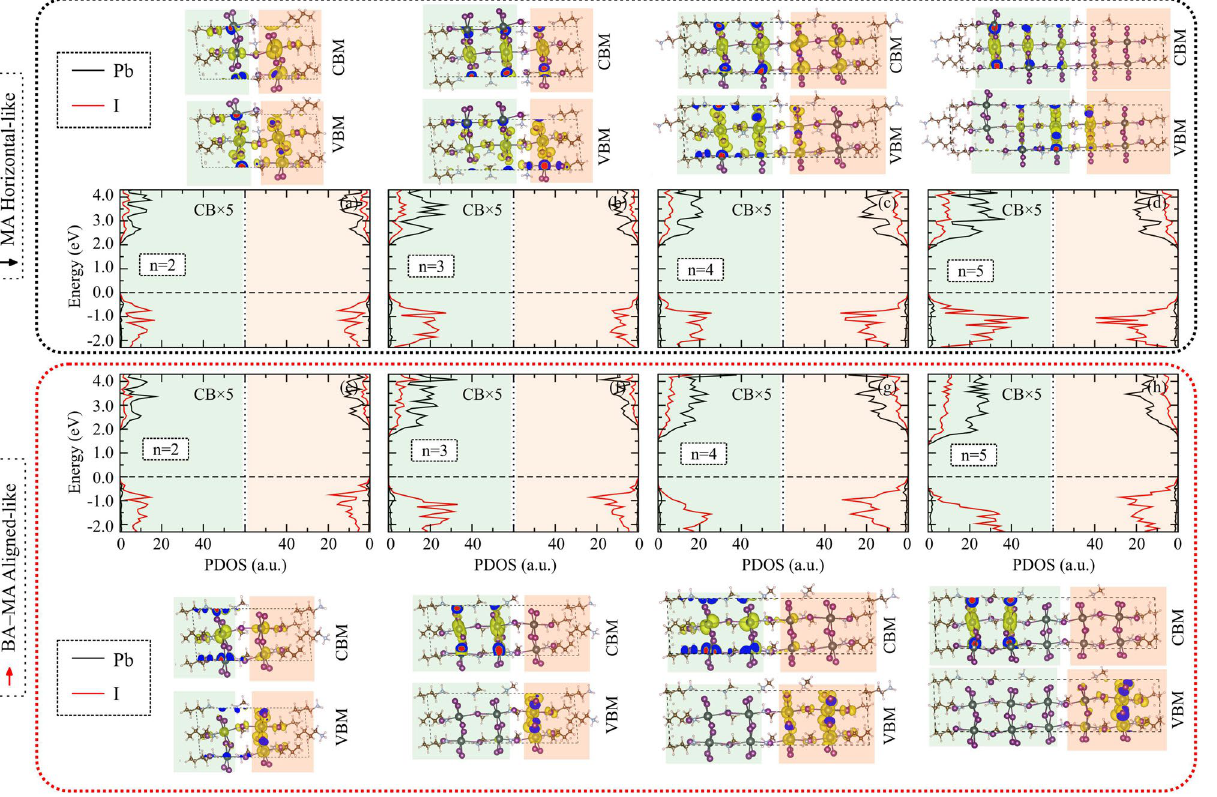
Figure 4. Projected density of states (PDOS) in the respective planes indicated by the corresponding blue and pink colors for the shaded regions in BA 2 MA n − 1 Pb n I 3 n + 1 for MA horizontal-like, from ( a ) to ( d ), and BA-MA aligned-like, from ( e ) to ( h ). Orbital representations in VBM and CBM are above and below the PDOS for MA horizontal-like and BA-MA aligned-like configurations, respectively. All the calculations were performed through PBE+D3+SOC-1/2